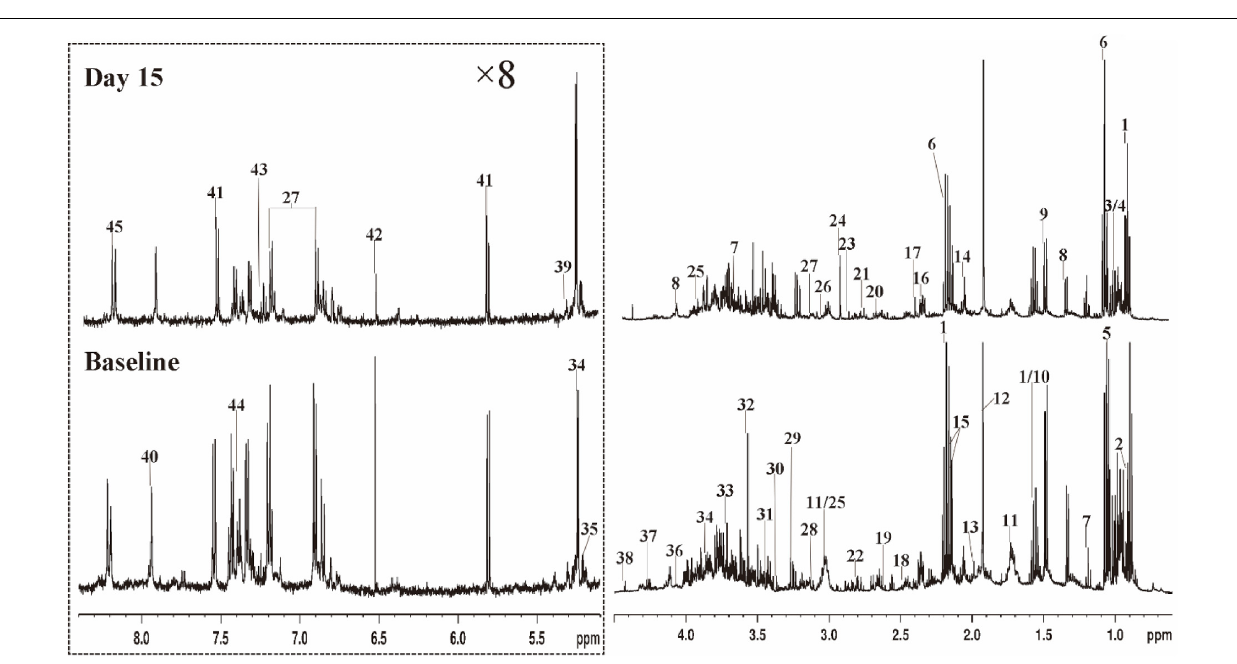
Frontiers in Nutrition |